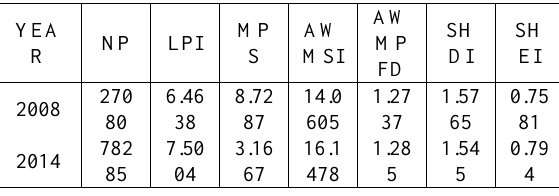
Table 1. Landscape pattern index calculated by adding desertification data in a